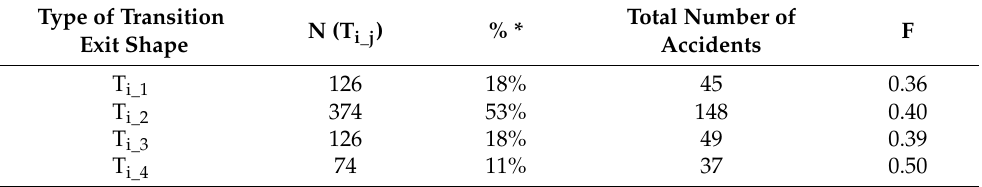
Table 4. Aggregate analysis (rural and urban areas) of data related to the transition exit shape. % * is the percentage of access points with the same type of transition exit shape compared to the total number of accesses that were noted.